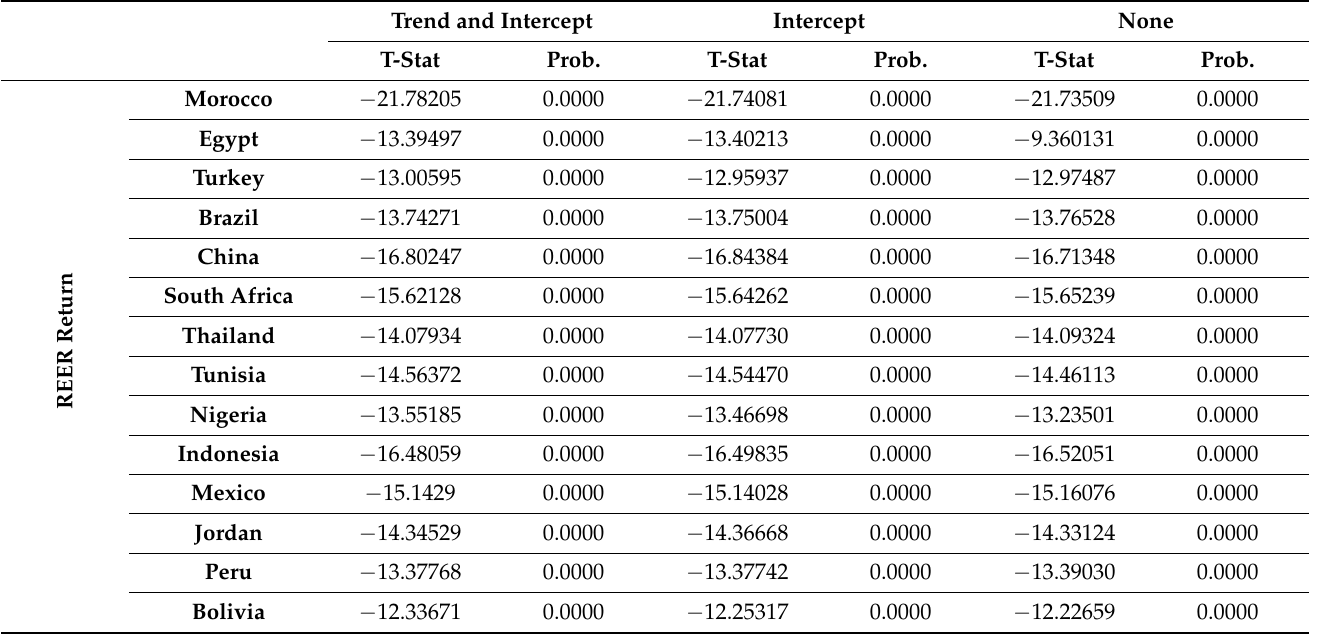
Table 4. Dickey–Fuller Test